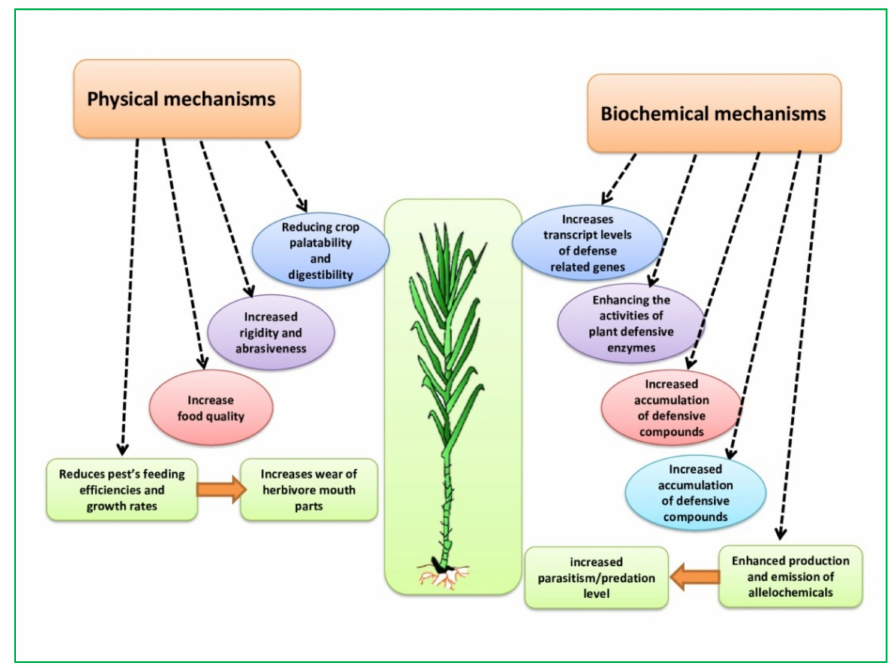
Figure 1. Schematic representation of interaction of silicon with arthropod pests